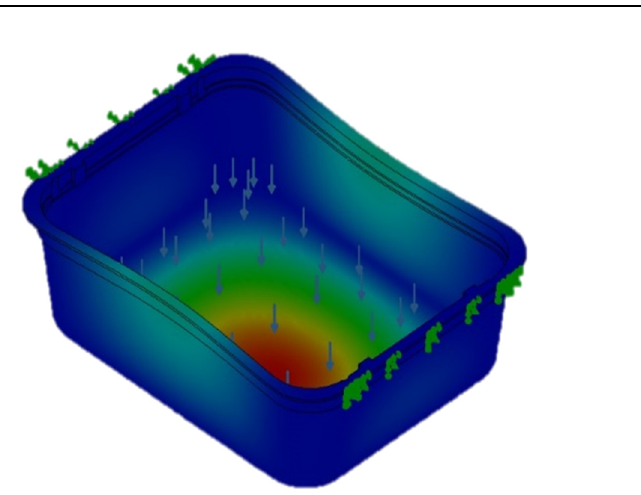
Figure 10. Example of the deformation results for the second simulation of the food tray. Table 8. Results for the second simulation for commercial polymers.